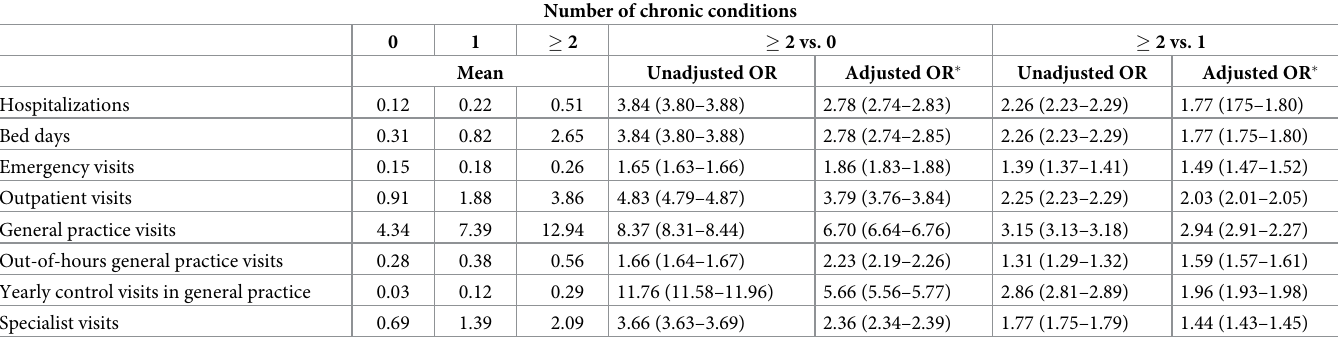
Table 3. Mean and odds ratios (ORs) for healthcare utilization among individuals with 0, 1, and � 2 chronic